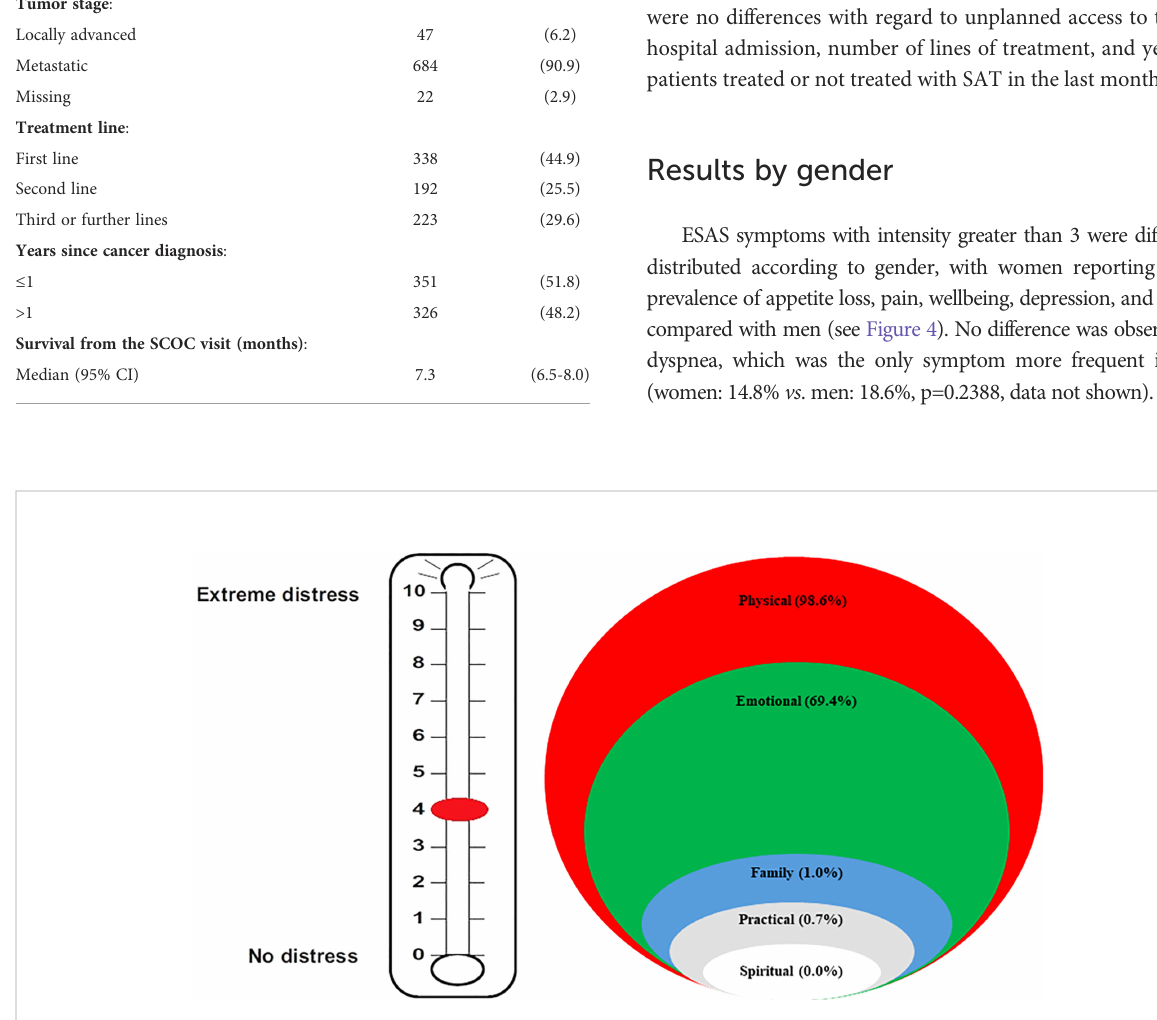
FIGURE 1 Results according to distress thermometers: median score and burden of distress in the different areas.